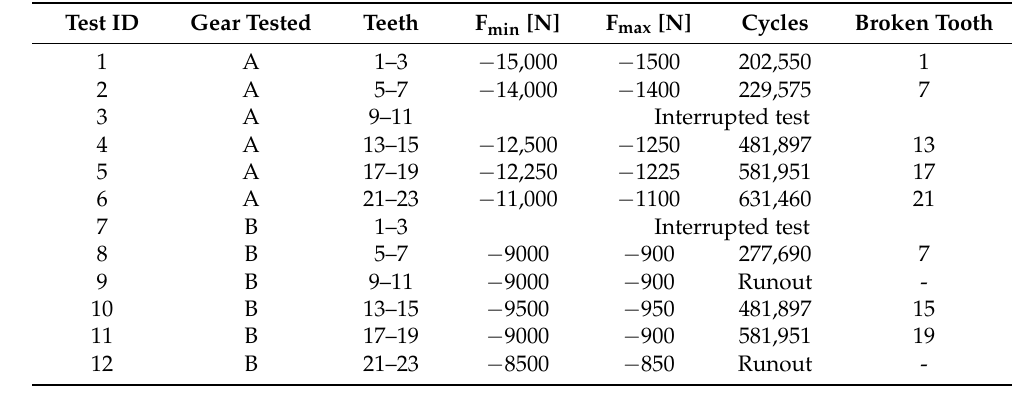
Figure 4. σ 𝐹0 − 𝑁 curve. Figure 4. σ F 0 − N curve. Table 3. Experimental points. Table 3. Experimental